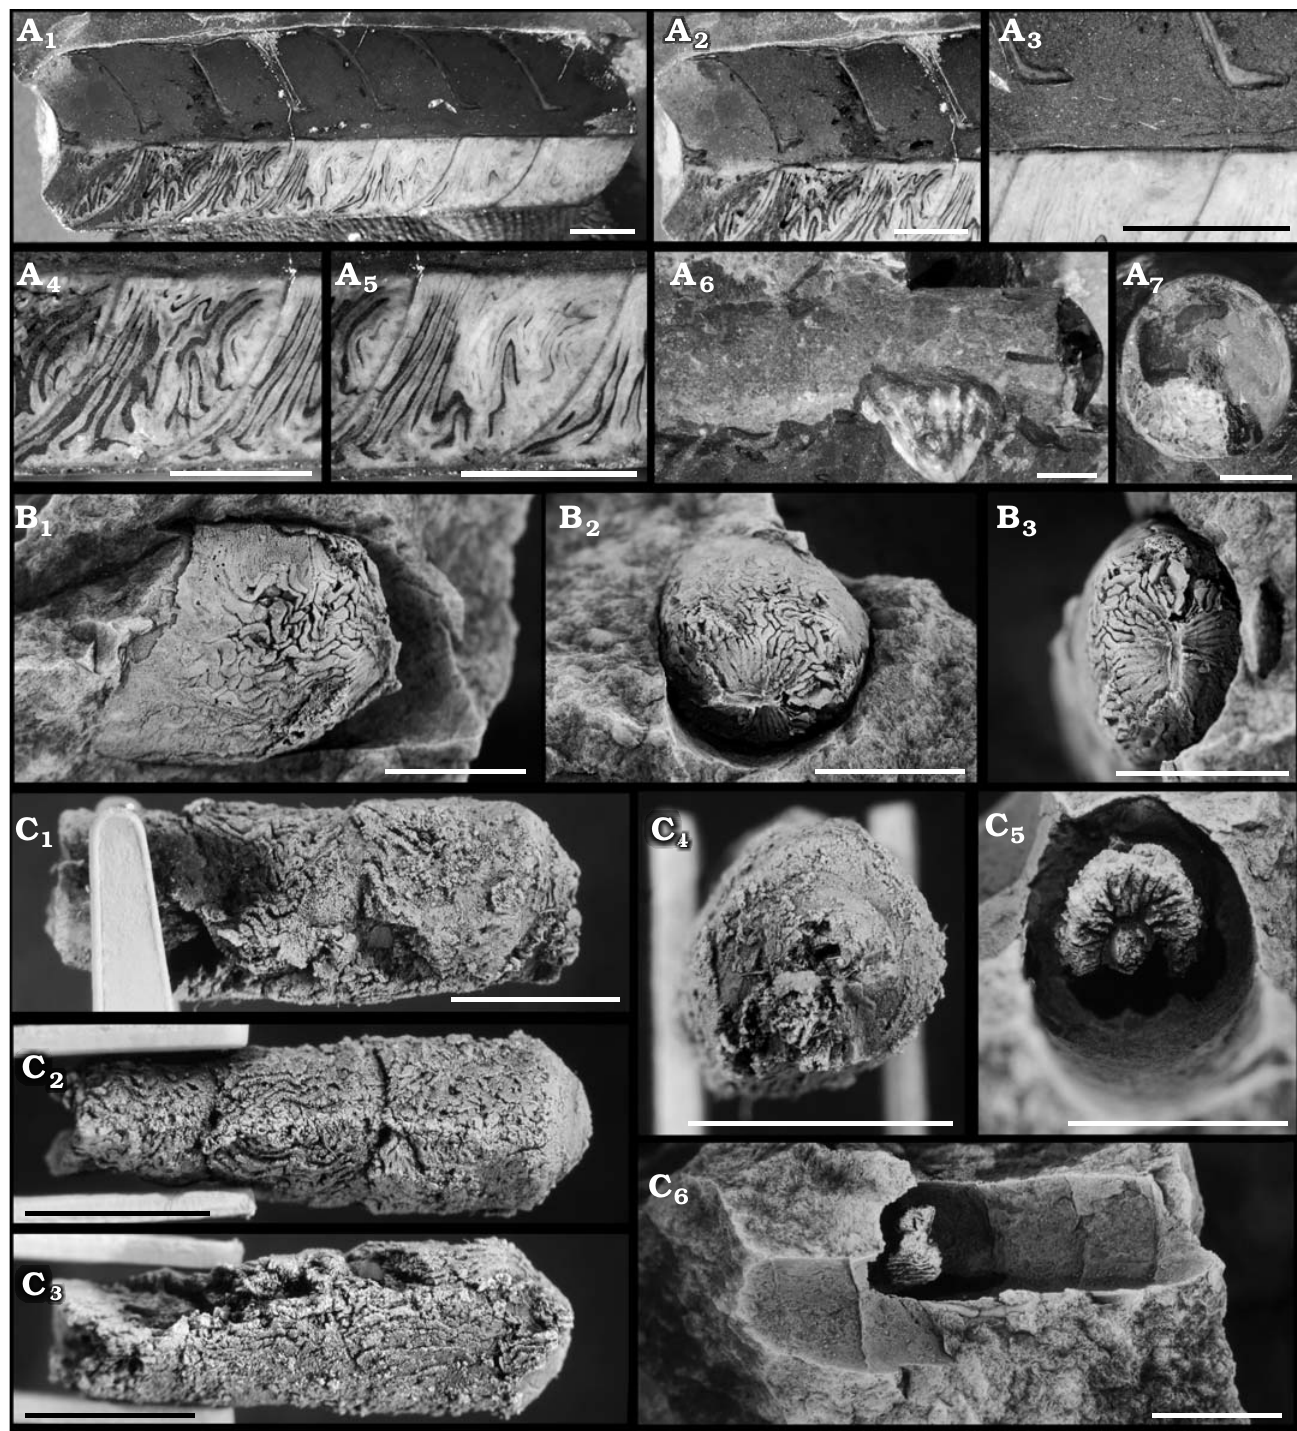
Fig. 2. Lamellorthoceratid cephalopod Arthrophyllum sp. from the Lower Devonian Talacasto Formation in the Precordillera Basin, Argentina. A . CEGH- UNC 27426, general view of the longitudinal section of the specimen (A 1 ), details showing a closer view of the lamellae and siphuncle structure (A 2 –A 5 ), external view (A 6 ), specimen before cutting in posterior view (A 7 ). Note the lamellar deposits where the septum is removed. B . CEGH-UNC 27427, specimen in lateral view (B 1 ), posterior views with different orientations (B 2 , B 3 ). C . CEGH-UNC 27428, lateral views of the internal mould with